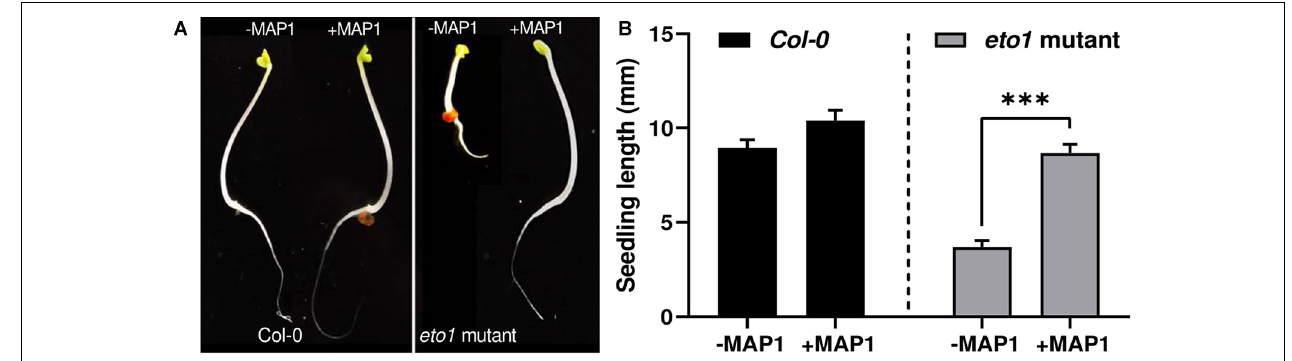
FIGURE 2 | eto1 -MAP1 co-culturing assay. (A) Phenotypic analysis showing comparison of MAP1-inoculated, etiolated seedlings of Col-0 accession and eto1 mutant (Col-0 background) with non-inoculated seedlings. (B) Growth kinetics of Col-0 and eto1 mutant seedlings. Quantitative data represent means ± SD of three independent experiments and at least 10 technical replicates each. The asterisks indicate a significant difference compared to untreated control ( ∗∗∗ p ≤ 0.005).